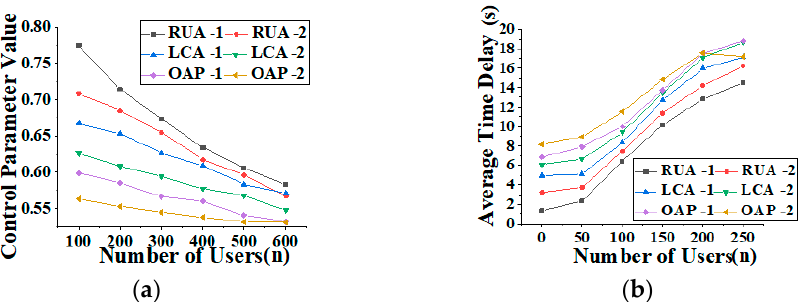
Figure 11. Variation trends of the system fixed control parameters and average delay with the increase in users: ( a ) changing curves of the system fixed control parameters with the increase in users; ( b ) changing curves of the average system delay with the increase in users.